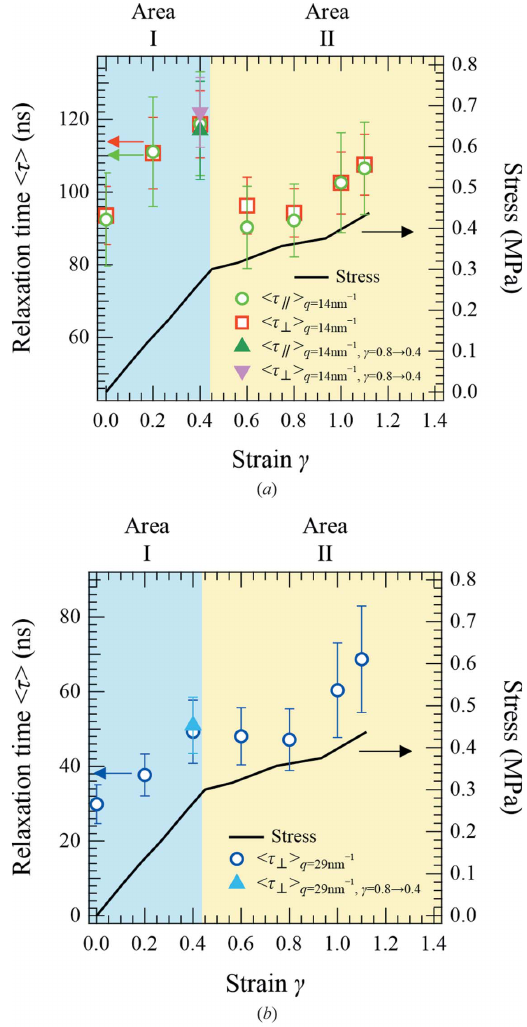
Figure 5 ( a ) Strain dependences of the mean relaxation times h (cid:3) i at q = 14 nm (cid:2) 1 in the directions parallel (green open circles, green filled up-triangles) and perpendicular (red open squares, magenta filled down-triangles) to elongation of the crosslinked PB. ( b ) Strain dependences of the mean relaxation times h (cid:3) i at q = 29 nm (cid:2) 1 in the direction perpendicular to elongation (blue open circles, cyan filled up-triangle) of the crosslinked PB. The cyan filled up-triangles, the magenta filled down-triangles and the green filled up-triangles represent the values of h (cid:3) i when the crosslinked PB was stretched to (cid:2) = 0.8 and then deformed to (cid:2) = 0.4. The black solid lines represent the stress–strain